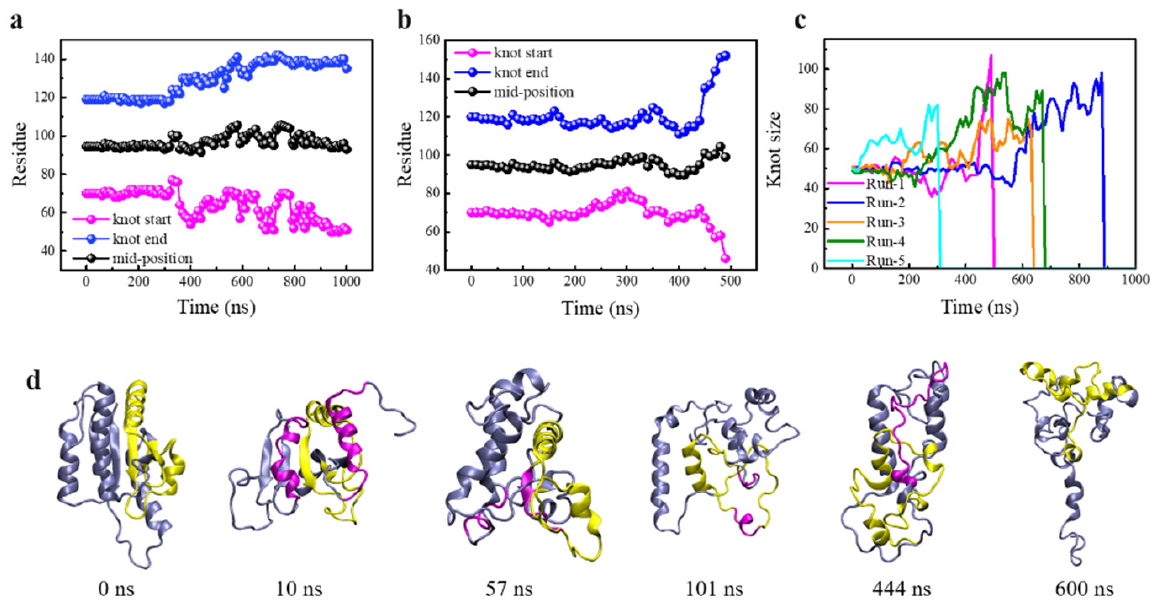
Figure 6. Thermal denaturation of knotted protein YbeA with specific residues mutated. ( a ) Time evolutions of the knot termini and mid-position change in YbeA with two residues Pro128 and Pro130 mutated to Ala. ( b ) The knot position change in YbeA with three residues Pro128, Pro130 and Trp120 mutated to Ala. ( c ) Time evolutions of the knot size in YbeA with three residues mutated in five independent simulations under the same thermal denaturing condition. ( d ) Time sequence of typical snapshots in one simulation depicting the detailed processes of protein unfolding and knot untying. The knotted region is colored in yellow. The major secondary structural change at each step is highlighted by purple coloring.